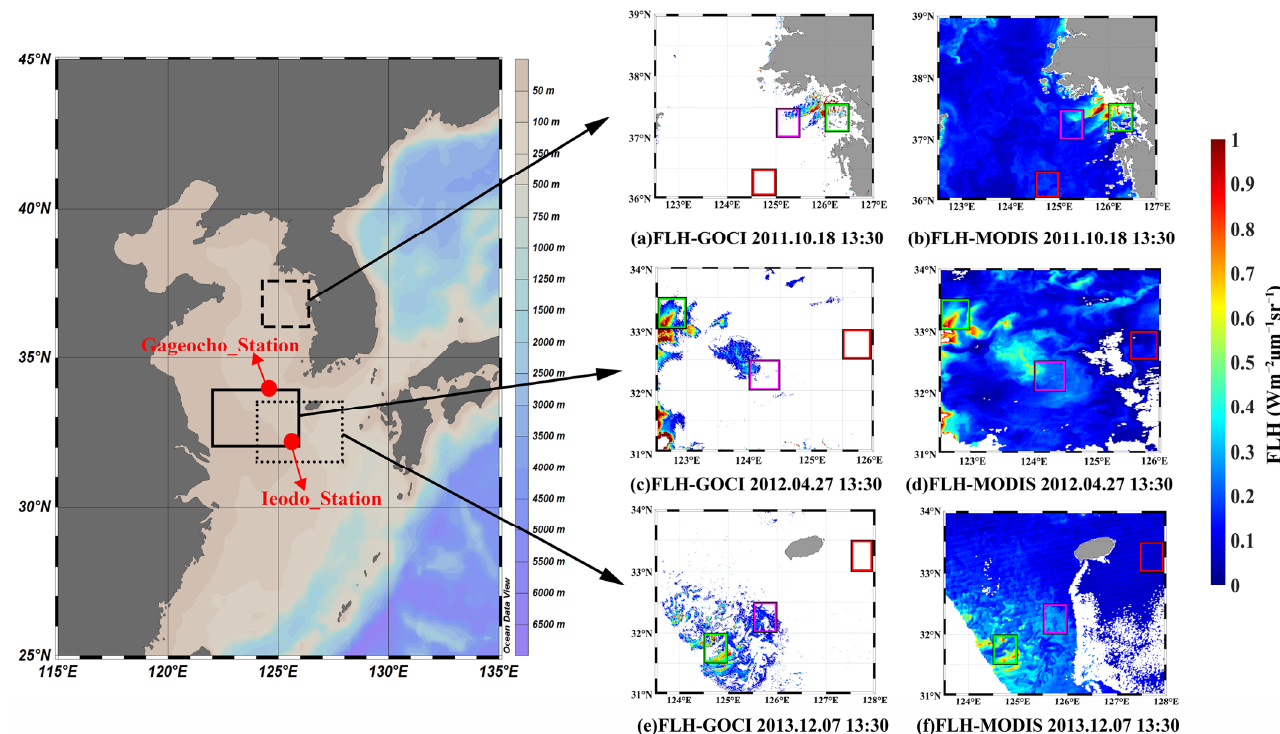
Figure 1. FLH inversion results of GOCI compared with the FLH product of MODIS. The white area in the figure is the invalid value area, which may be caused by cloud cover or by failure of the FLH algorithm. The framed areas in panels ( b , d , f ) are the areas selected for study. The green frame is the nearshore water area, the purple frame is the continental shelf water area, and the red frame is the clear ocean water area. The two red dots are the locations of the AERONET-OC stations used in this study (The station names are: Gageocho_Station and Ieodo_Station).